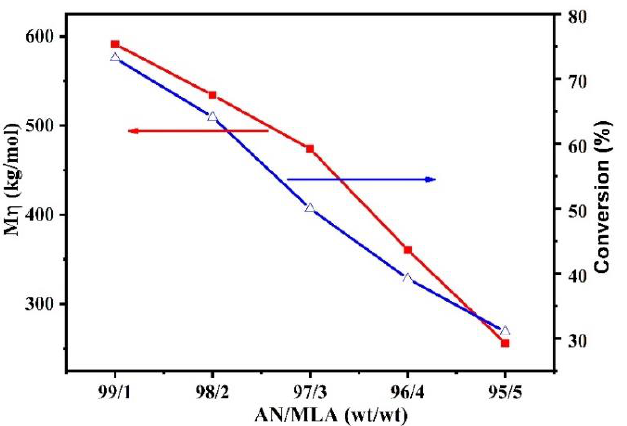
Figure 2. The effect of monomer feed ratios on copolymer conversion and molecular weight. Table 2. Effect of monomer feed ratio on relative molecular mass and its copolymer dispersion. AN/MLA